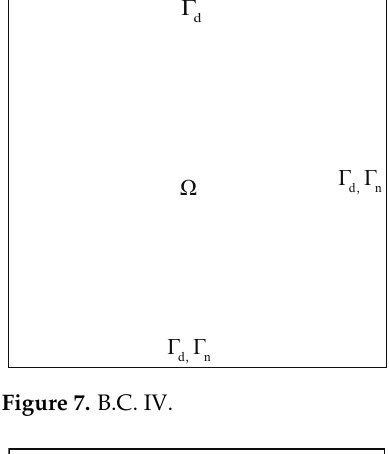
Table 4. Experiment results for the exact solution u = x 2 e y with B.C. I.